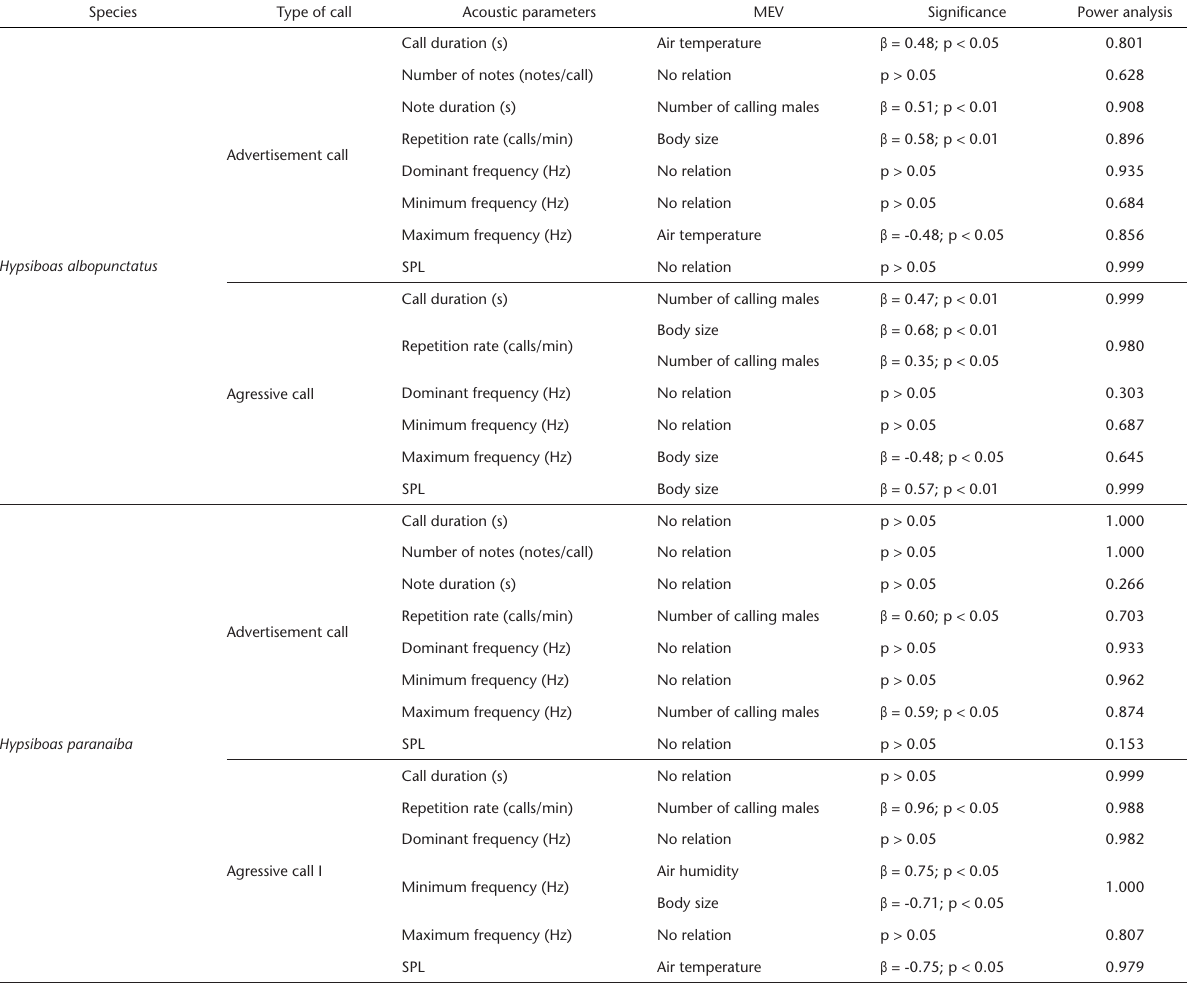
Table 3. Results of multiple regressions of morphological and environmental variables (MEV) with acoustic parameters of Hypsiboas para- naiba and H. albopunctatus and values observed in power